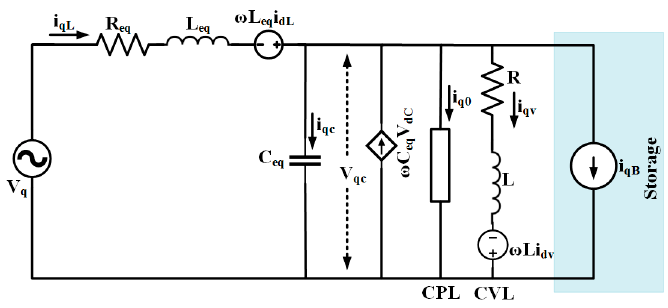
Figure 8. q-axis model of the load side reactive power compensation method.